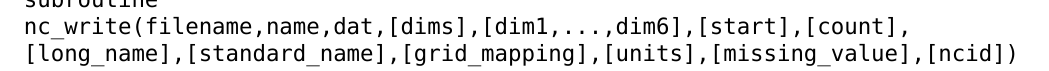
Table A8. Subroutine call and argument descriptions for nc_write . subroutine